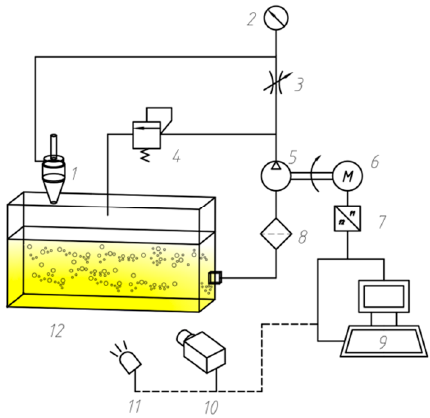
Table 2. Performance parameters of three-screw pump.